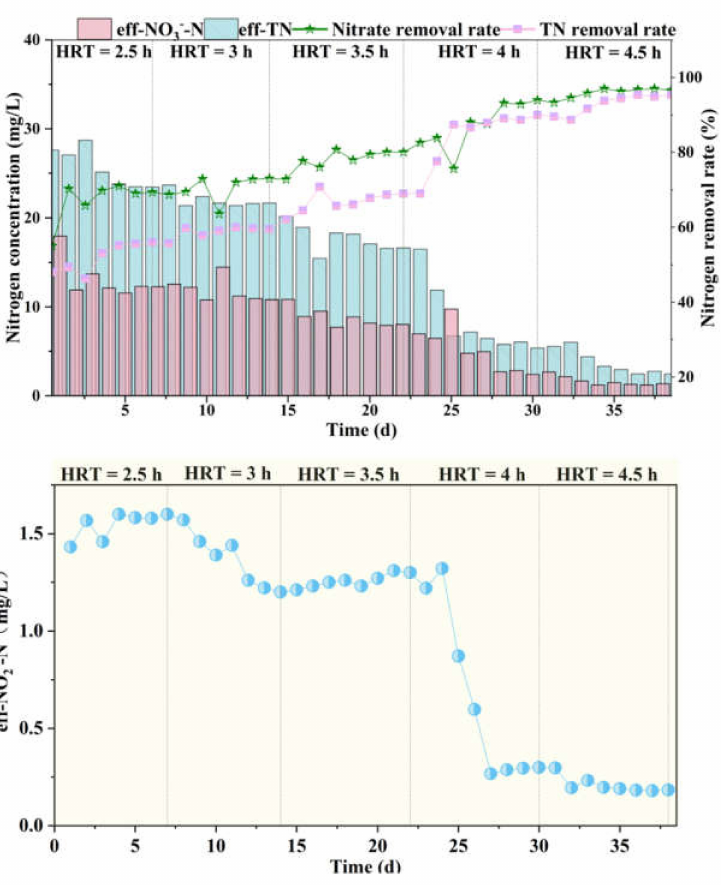
Figure 4. Concentrations of NO − different HRT.